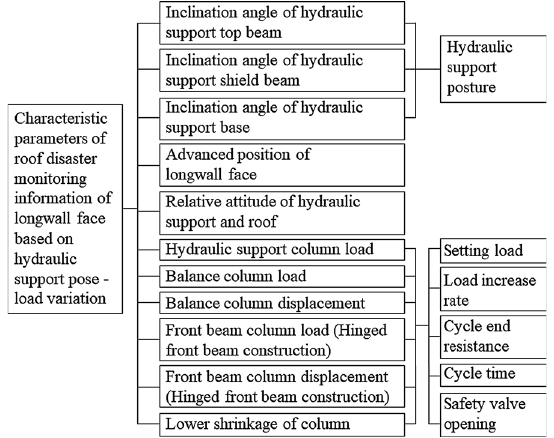
Fig. 3 Monitoring information characteristic parameters of longwall face roof